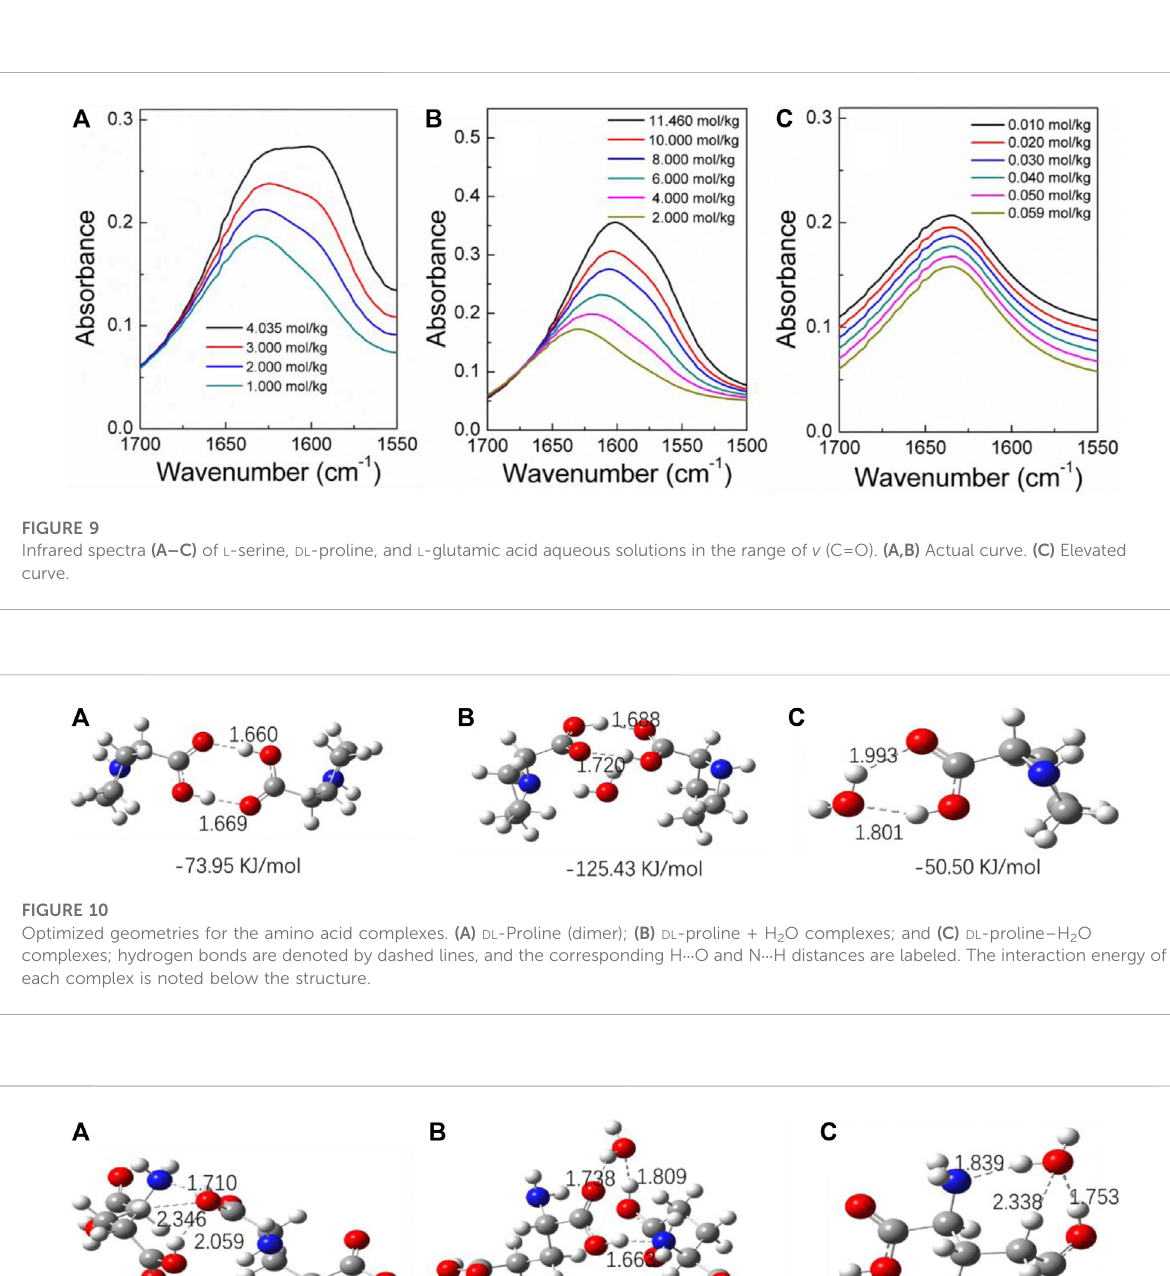
experimental pressure, and P cal represents the calculated pressure.